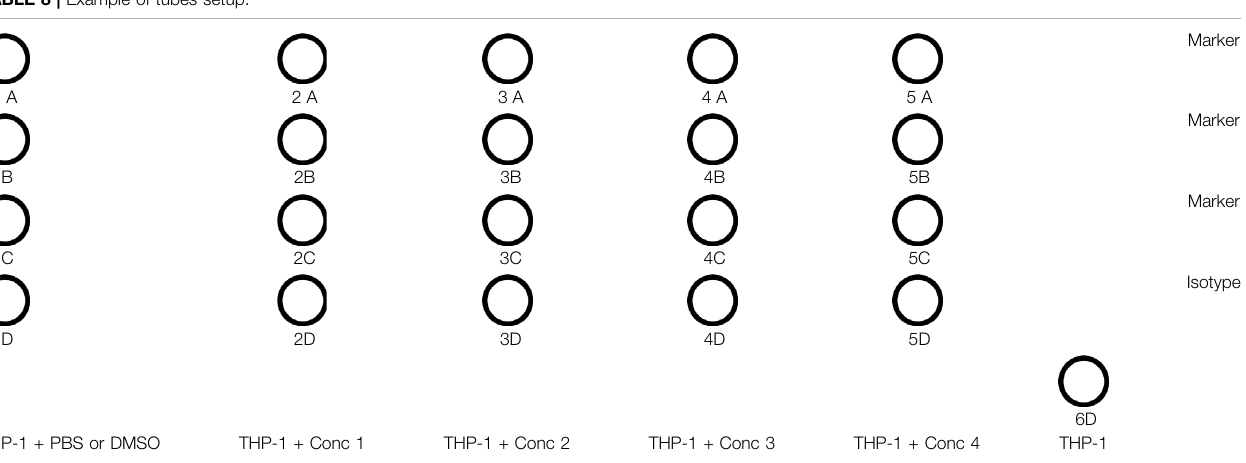
TABLE 8 | Example of tubes